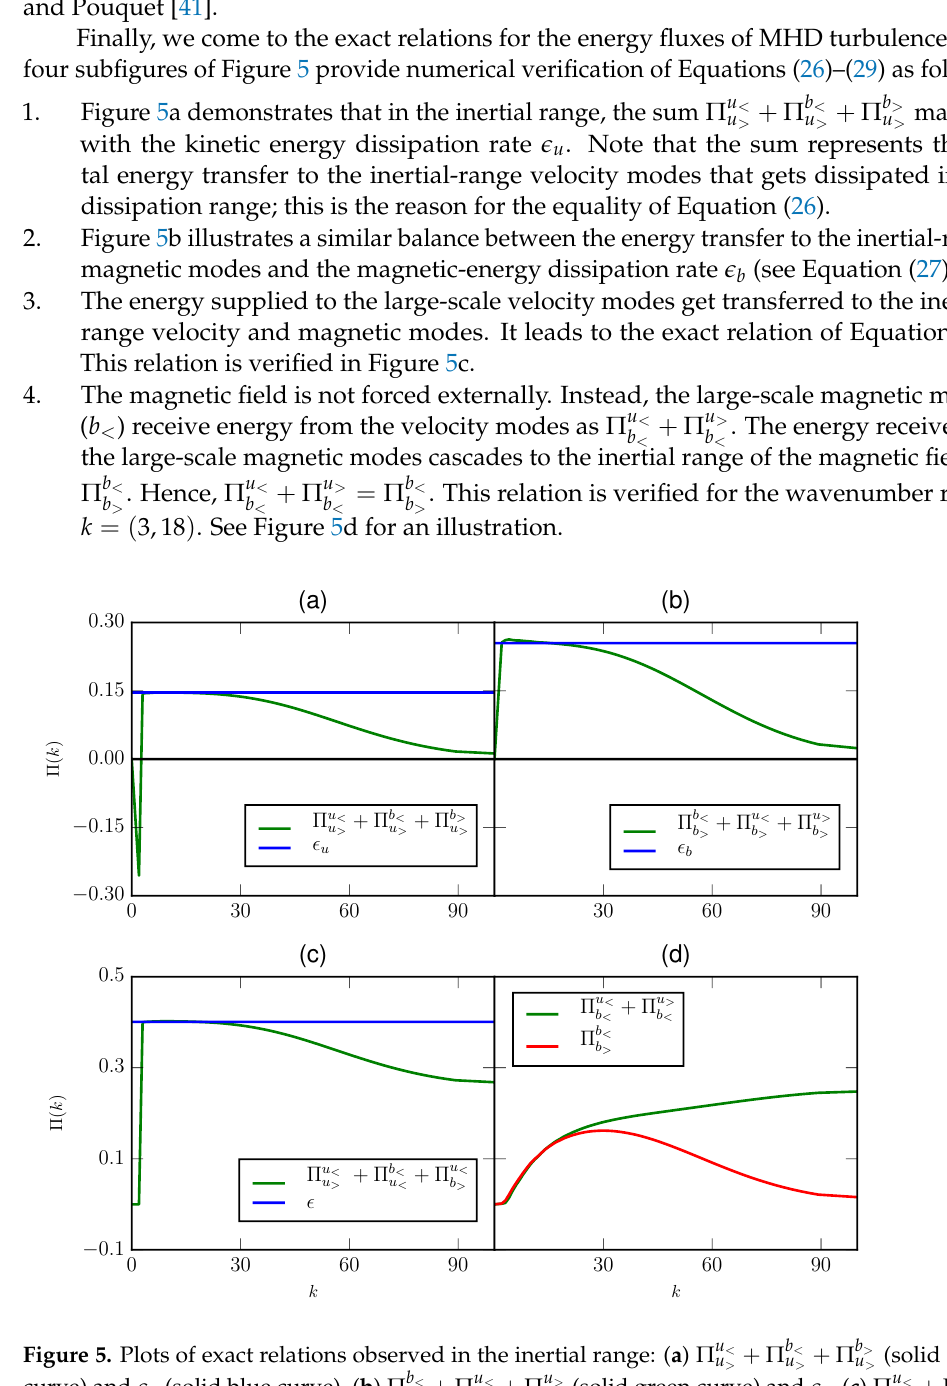
+ Π u < + Π u > (solid green curve) and (cid:101) b , ( c ) Π u < u b > b > b >